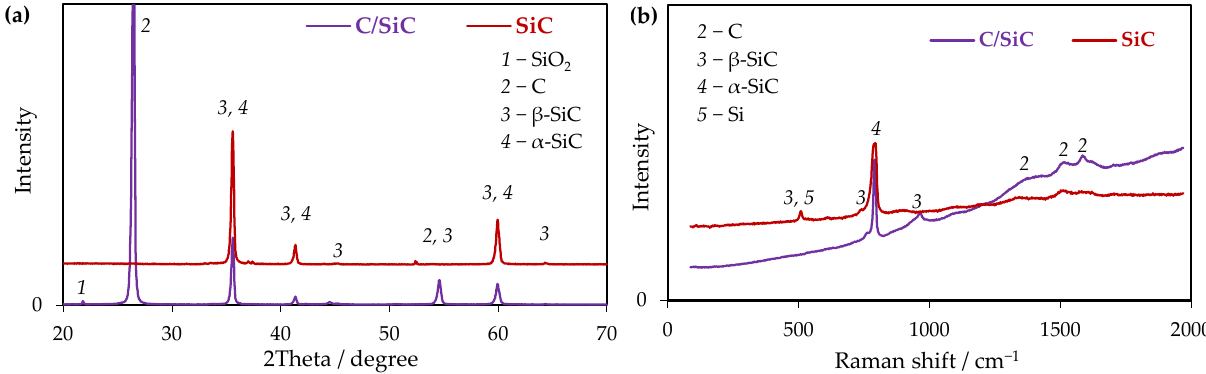
Figure 4. X-ray diffraction patterns ( a ) and Raman spectra ( b ) for the obtained C/SiC and SiC sam- ples.